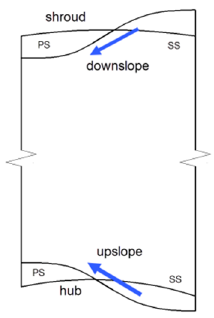
Figure 15. Sketch of the rules for the profiled endwall.